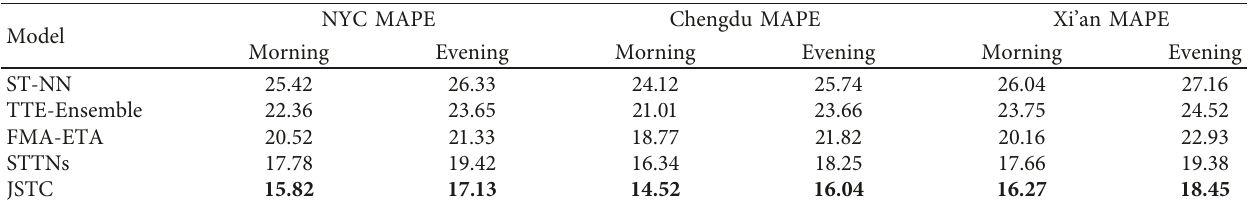
Table 4: An illustration of all models’ performances with morning and evening peak periods (MAPE) for NYC, Chengdu, and Xi’an. NYC MAPE Model